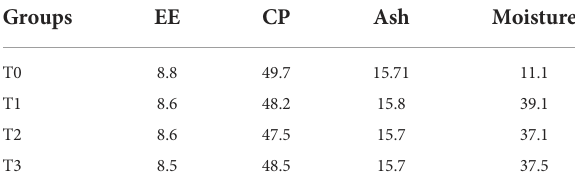
TABLE 2 Nutrient composition of the basal and experimental